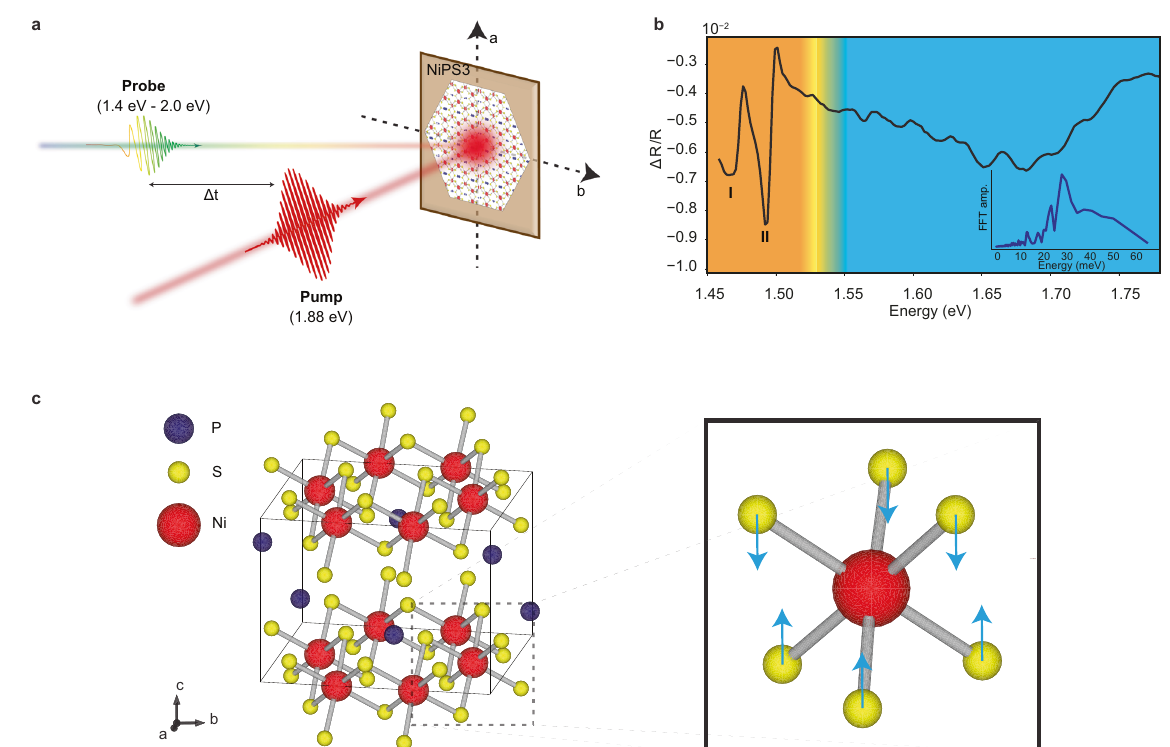
Fig. 1 Phonon replicas observed in the transient absorption spectrum of NiPS 3 . a Schematic of the broadband transient absorption spectroscopy setup. A pulse with energy (1.88 eV) larger than the bandgap excites the system, and a subsequent probe pulse with white light continuum measures the transient re fl ectivity in a broad spectral region, with 1.5 meV spectral resolution. b Spectral dependence of transient re fl ectivity measured at 10K, 2 ps after the pump. Previously reported coherent many-body spin – orbit-entangled excitons (orange region) and a broad d – d transition (blue region) can clearly be seen. Two sharp features are labeled as Peak I and Peak II which have been previously identi fi ed as a spin – orbit-entangled exciton and a magnon sideband 11 . The d – d peak is dressed by phonons, with at least 9 replicas visible, indicating a strong coupling between them. The inset shows the Fourier transform of the extracted spectral oscillations, with a mode peaking at 28.5 meV, which is close to the 7.5 THz A 1g phonon energy. c Crystal structure of NiPS 3 . Octahedron as shown in the solid square, formed by a nickel (red) and six sulfur (yellow) atoms. Phosphorus atoms are shown in dark blue. Arrows indicate the A 1g phononic displacements for the 7.5 THz A 1g